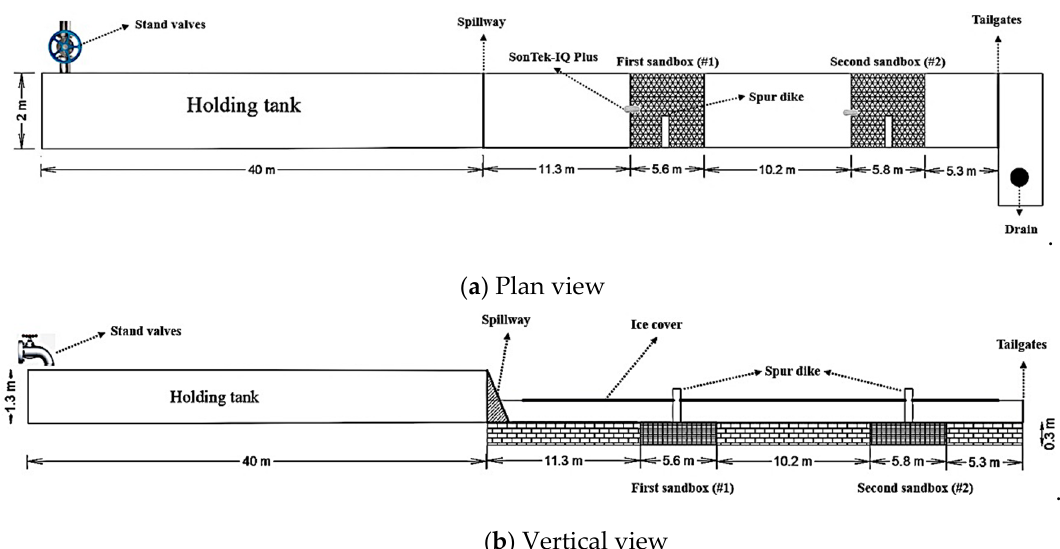
Figure 1. The layout of the experimental flume: ( a ) Plan view; ( b ) vertical view. Due to the slope of the flume, water levels varied gradually from upstream to downstream. Therefore, the flow was classified as a nonuniform flow. Another important feature that influences the flow is the aspect ratio B/H (where B is the channel width and H is the flow depth), which is used to classify the channel (flume) either as a narrow (B/H < 5) or wide (B/H > 5) channel. A flow in a narrow channel is affected by the secondary currents from the banks (flume side walls) and causes the dip phenomena (the maximum velocity occurs below the flow surface). However, in the wide channel, the strength of the secondary currents reduces in the lateral direction of the flume [18]. In this experimental study, since the deepest flow depth was 35 cm and the flume width was 200 cm, all flows in this flume belong to wide channel flows (B/H > 5). There were two sandboxes which are spaced 10.2 m from each other. These sand- boxes were 2 m wide and 0.3 m deep. The upstream sandbox was 5.6 m long, and the downstream one was 5.8 m long (Figure 2). Three types of nonuniform sands with the median grain size (D 50 ) of 0.9 mm, 0.6 mm, and 0.48 mm were used in the sandboxes. One side of the flume wall along each sandbox was made of plexiglass to have a clear view of the scour process. A staff gauge was located in the middle of each sandbox to measure the water depth during experimental runs. The impermeable model spur dike, made of marine plywood (had a dimension of 80 cm height, 5 cm width, and 50 cm length), was installed in the middle of each sandbox. The model dike was placed at the bottom of each sandbox (namely, 30 cm buried in the sand) so that 50 cm of the model dike was exposed to the flow. Of note, the model spur dike was non-submerged for all experimental runs in this study. Figure 2. The view of the original site (experimental flume).